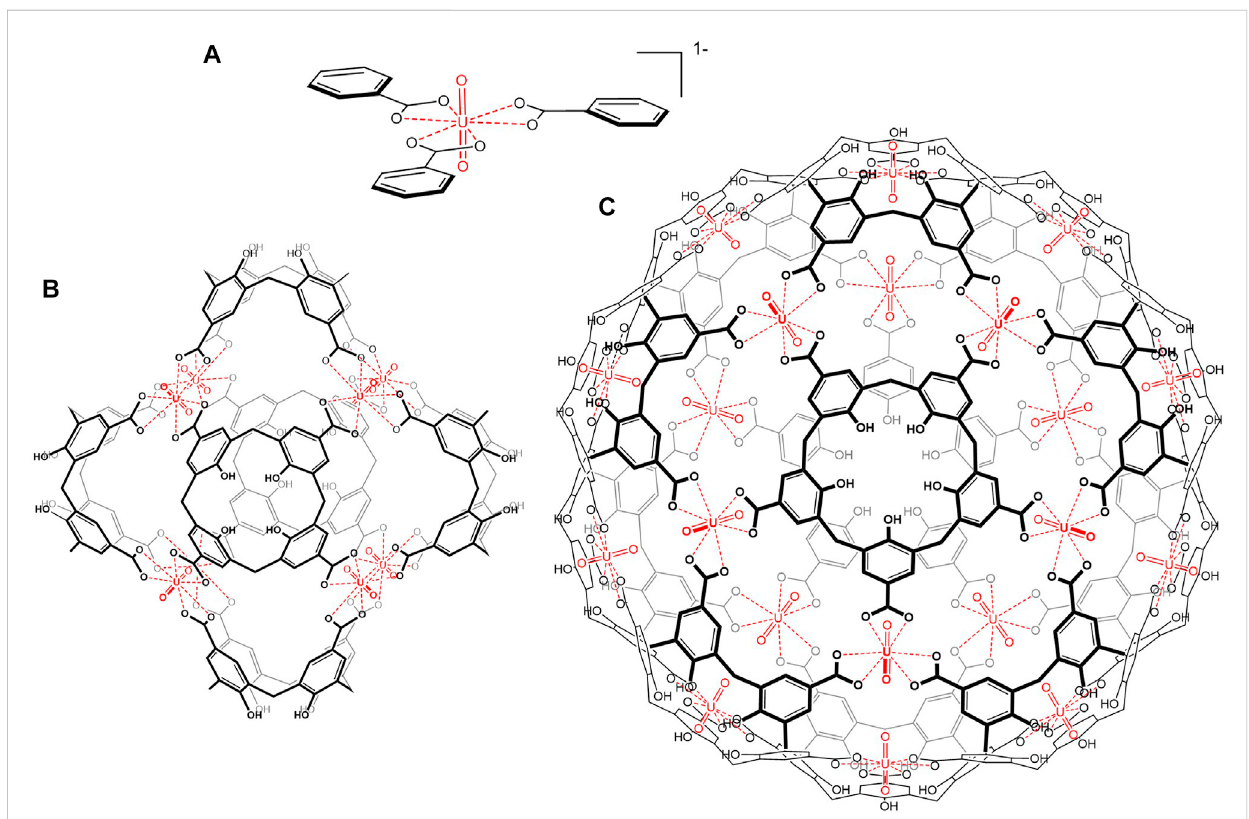
FIGURE 1 Hexagonal bipyramidal coordination of uranyl with carboxylates (A) and chemical structures of uranyl hexameric (B) and dodecameric (C) cages from calixarenes.